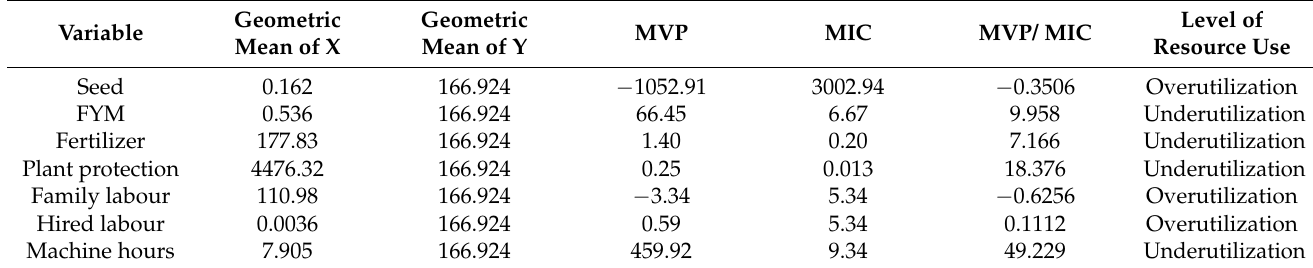
Table 11. Resource use efficiency of marigold cultivation in Kathua district.